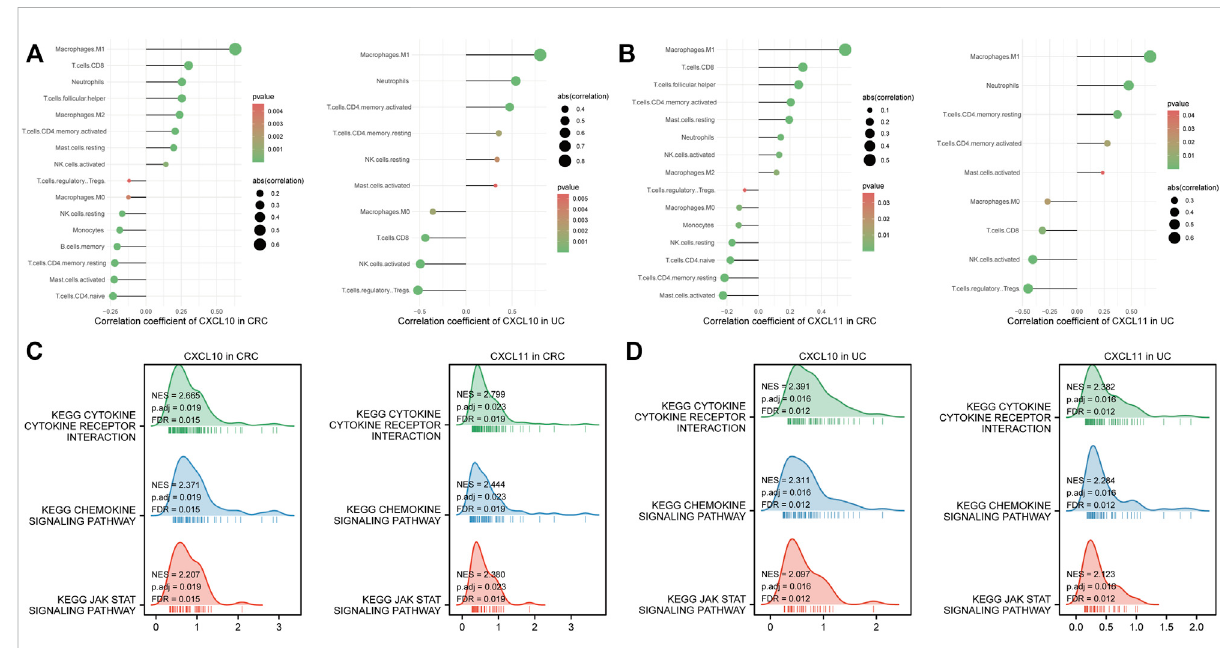
FIGURE 7 Immune in fi ltration and gene set enrichment analysis (GSEA) of survival-hub genes. (A) correlation analysis between CXCL10 and immune cell in fi ltration in the Cancer Genome Atlas Program (TCGA) and GSE75214 datasets, respectively. (B) correlation analysis between CXCL11 and immune cell in fi ltration in the TCGA and GSE75214 datasets, respectively. (C) GSEA of CXCL10 and CXCL11 in TCGA cohorts. (D) GSEA of CXCL10 and CXCL11 in the GSE75214 dataset. Abbreviation: CRC, colorectal cancer; UC, ulcerative colitis; KEGG, Kyoto Encyclopedia of Genes and Genomes; NK, natural